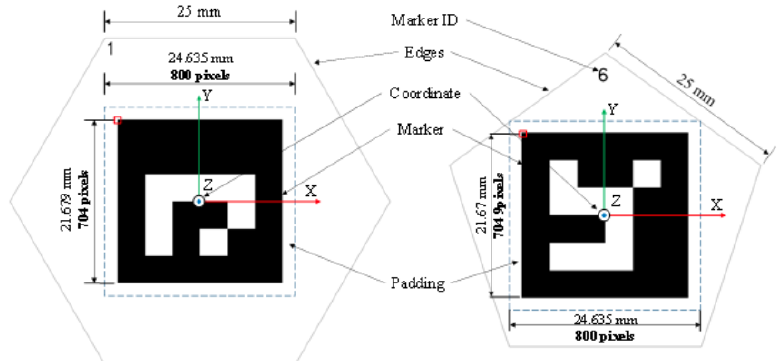
Figure 3. Detail of ArUco marker inside the hexagonal ( left ) and pentagonal boundary ( right ).